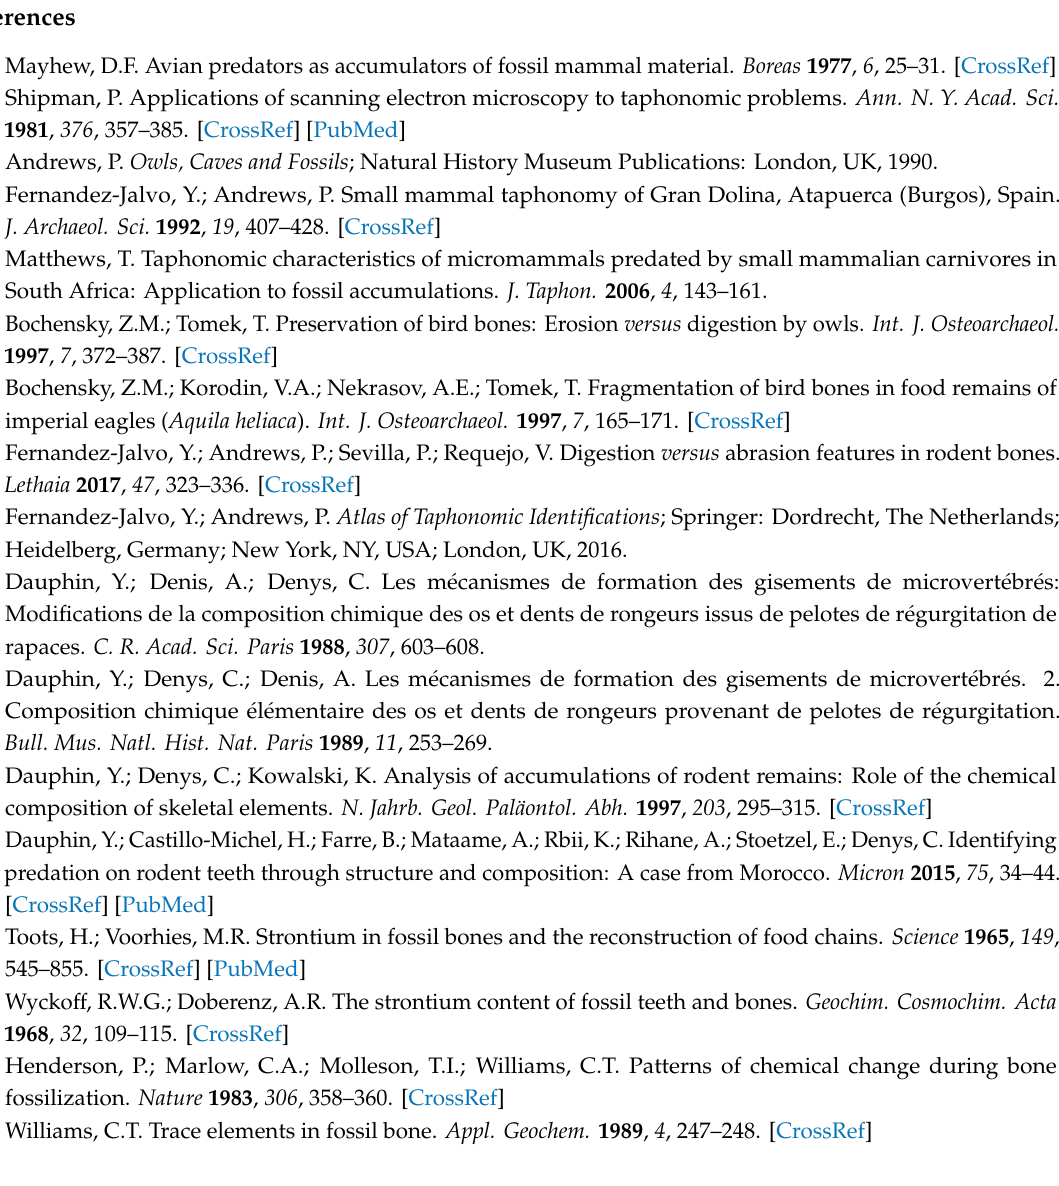
Figure S1: Location of Olduvai, Figure S2: Incisor structure, Figure S3: Chemical distribution maps, Figure S4: Evaluation of the preservation from Raman data, Table S1: Chemical analyses of teeth, Table S2: Statistical tests, Table S3: Some taphonomic